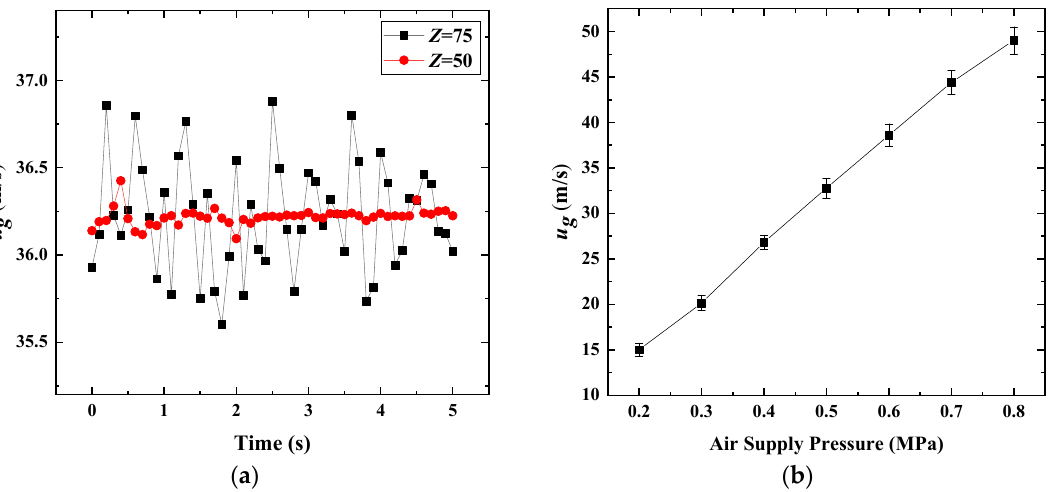
Figure 4. Characterization of the air crossflow velocity: ( a ) Air velocities at different moments and positions; ( b ) Average velocity and its SD at different air supply pressures.